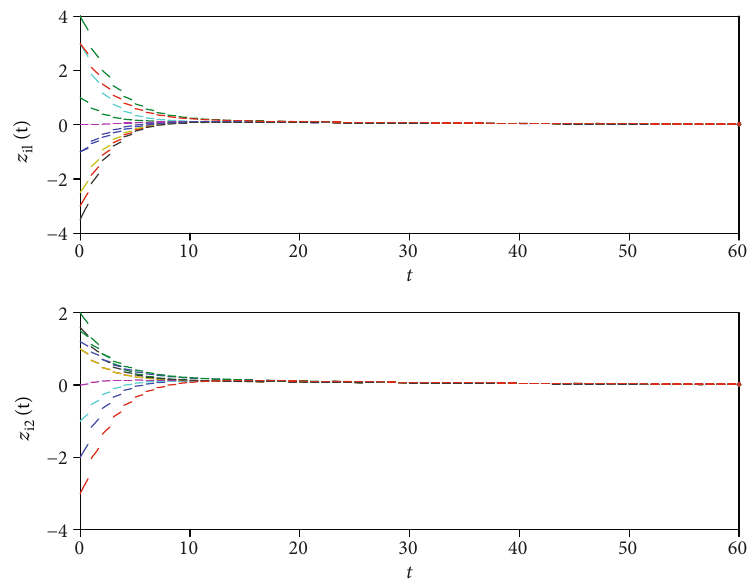
and z of the system (42) without control. i 1 i 2